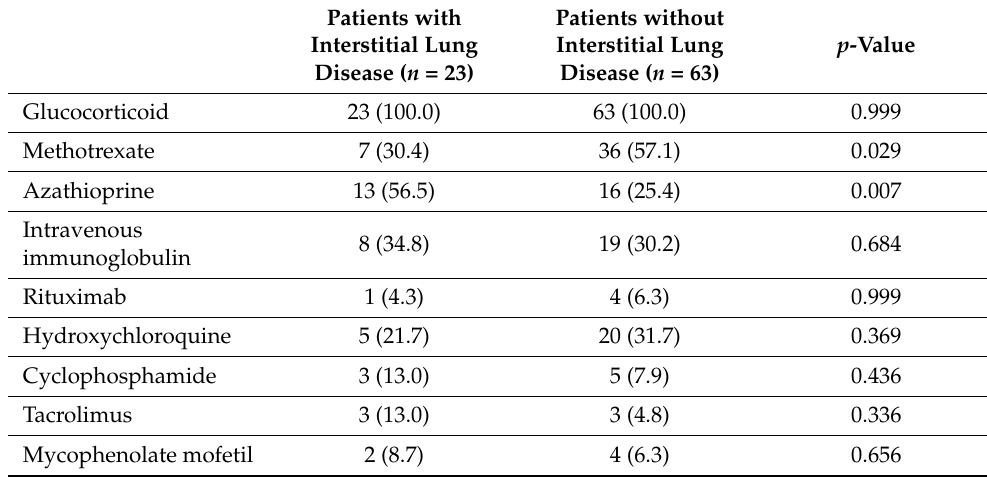
Table 4. Medication usage in patients with and without interstitial lung disease.